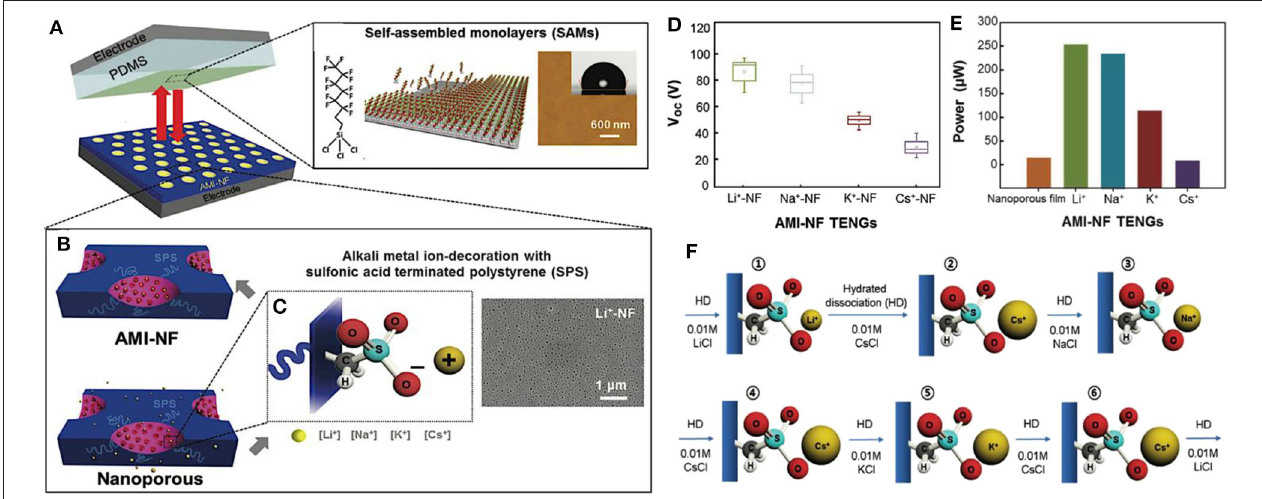
FIGURE 6 | Schematic diagrams and output performance of TENGs with ion-decorated triboelectric materials. (A) Schematic diagram of the structure of an AMI-NF TENG. (B) Schematic diagram of nanoporous structure on the surface of AMI-NF. (C) Partial enlarged schematics of alkali metal ion (Li + , Na + , K + , and Cs + ) association with sulfonate (SO − 3 ) functional groups on the surface of the nanopores. (D) Average V oc and (E) averaged maximum power of AMI-NF with various alkali metal ions. (F) Schematics of sequential alkali metal ion exchange on a nanoporous surface: ‹ Li + → › Cs + → fi Na + → fl Cs + → (cid:176) K + → – Cs + → ‹ Li + . Reprinted with permission from Park et al. (2017). Copyright 2017